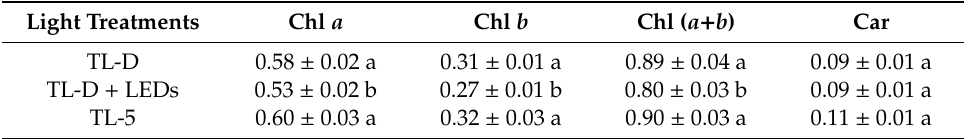
Table 3. Pigment concentration (expressed in mg g − 1 FW) in plants of F. verschaffeltii treated with different light treatments at the end of the experiment (8 weeks). Values with the same letters are not significantly different at p < 0.05 (ANOVA and LSD test). ns: not significant. Data are the means ± standard deviation of five plants per treatment.